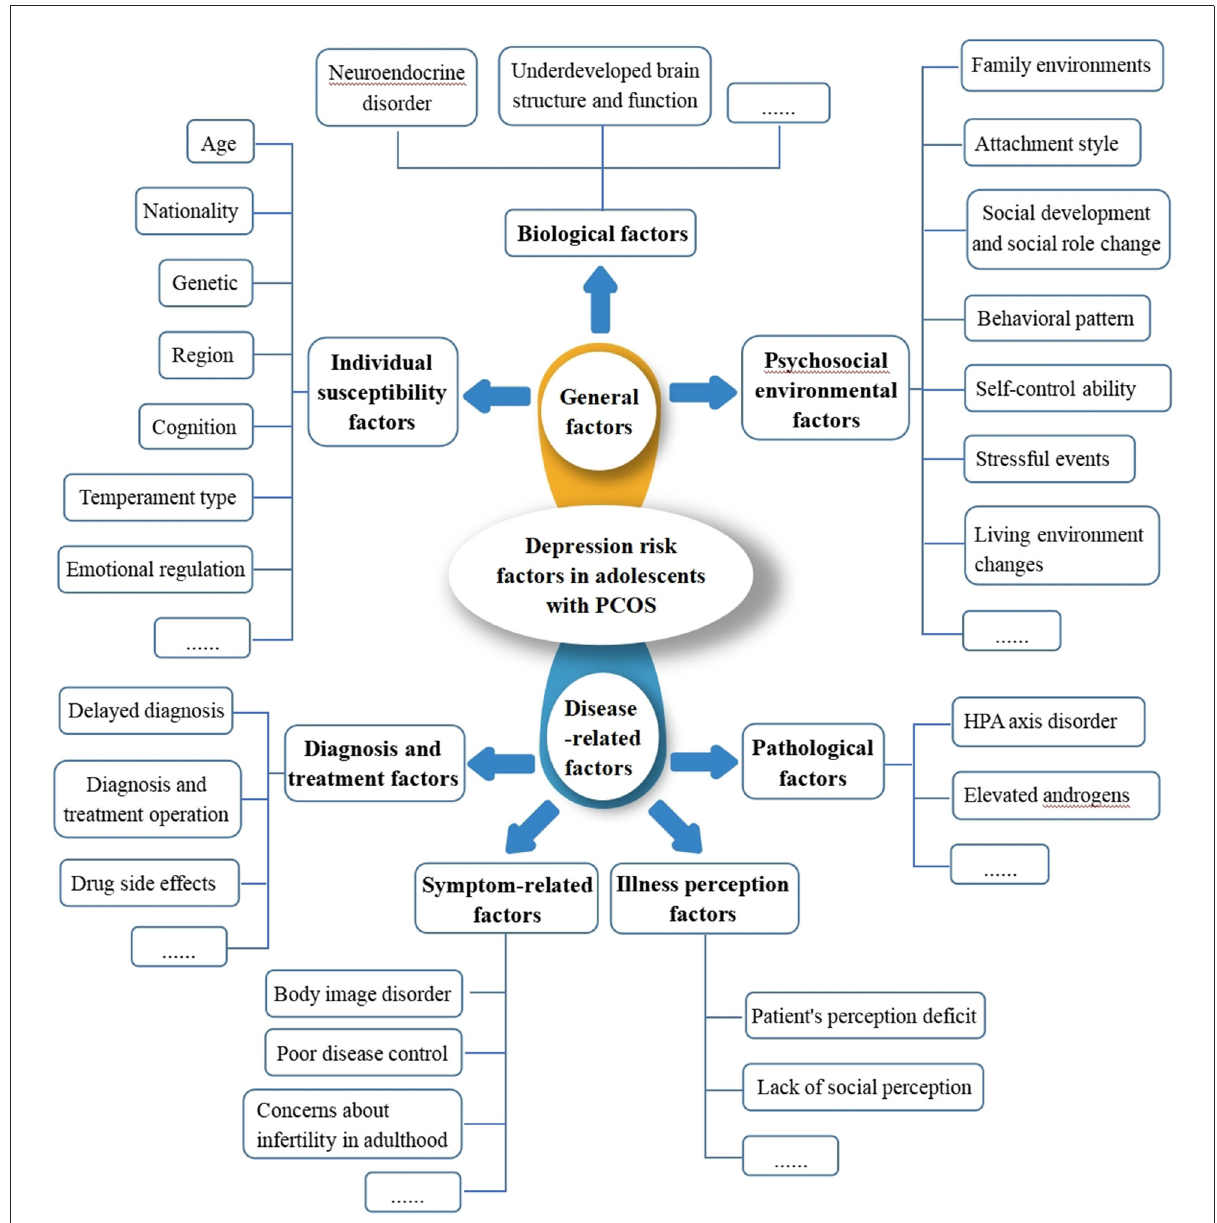
FIGURE1 Simulation map of risk factors for depression in adolescents with